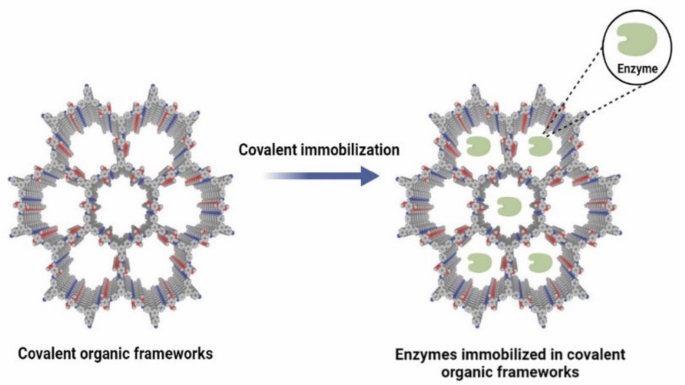
Figure 2. Covalent immobilization of enzymes in